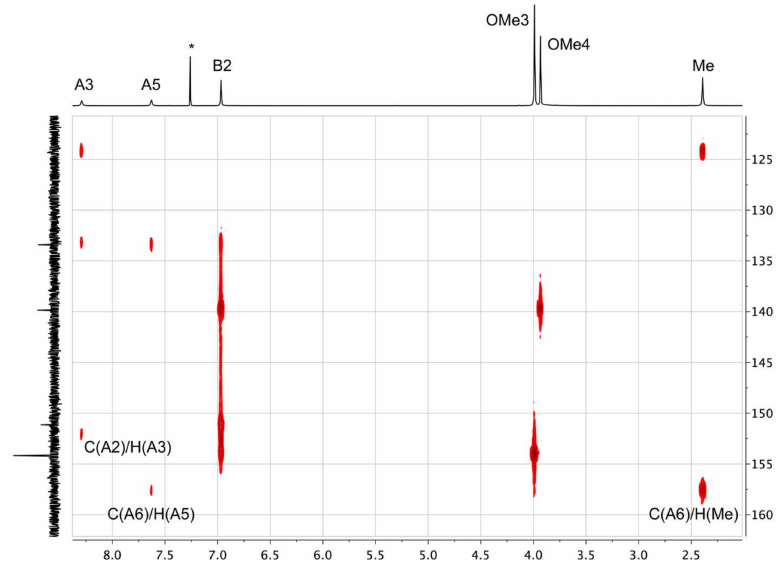
Figure 2. Part of the HMBC spectrum (500 HMz 1 H, 126 MHz 13 C) of [Cu( 4 ) 2 ][PF 6 ] (CDCl 3 ). * = residual CHCl 3